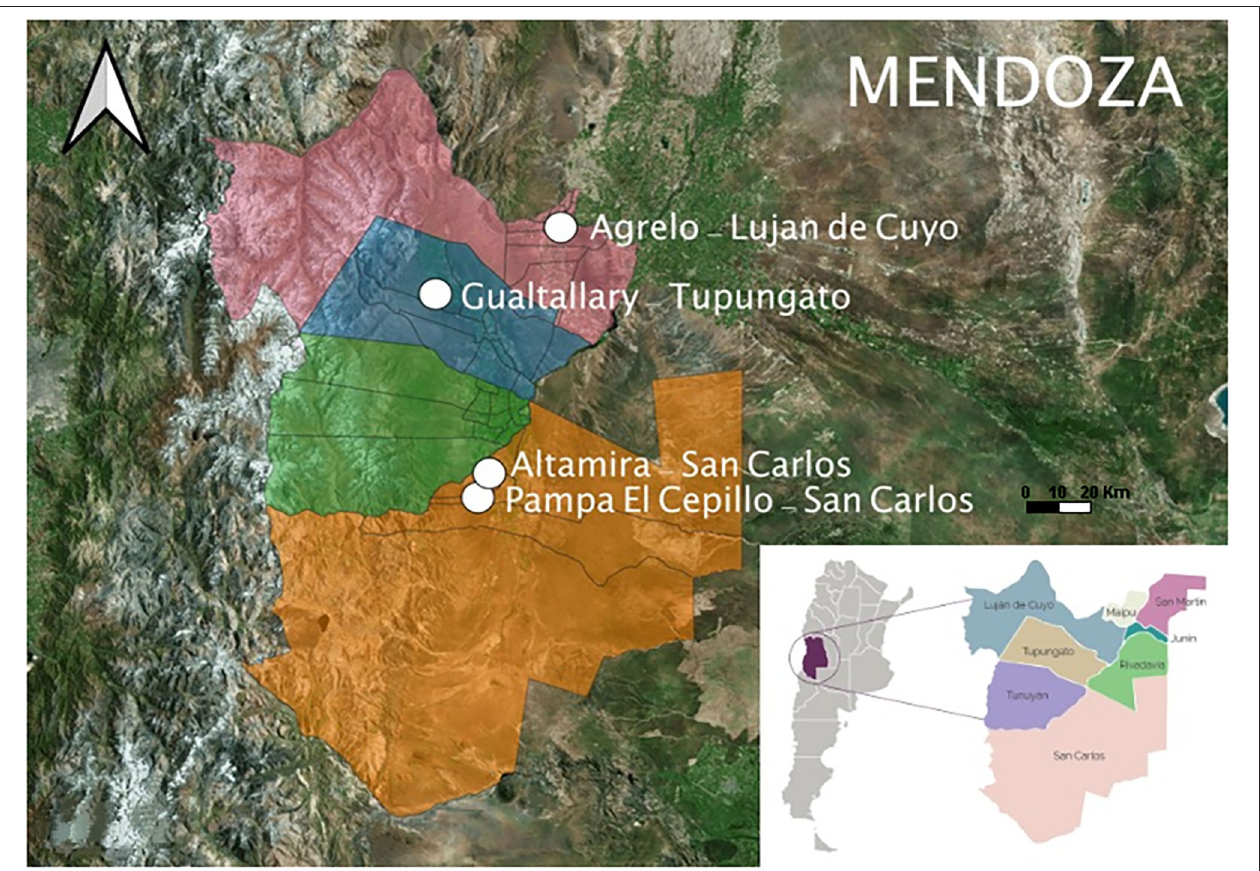
FIGURE 1 | Geographical location of individual parcels in the study area. The images were created using QGIS.org, 2021. QGIS Geographic Information System. QGIS Association.